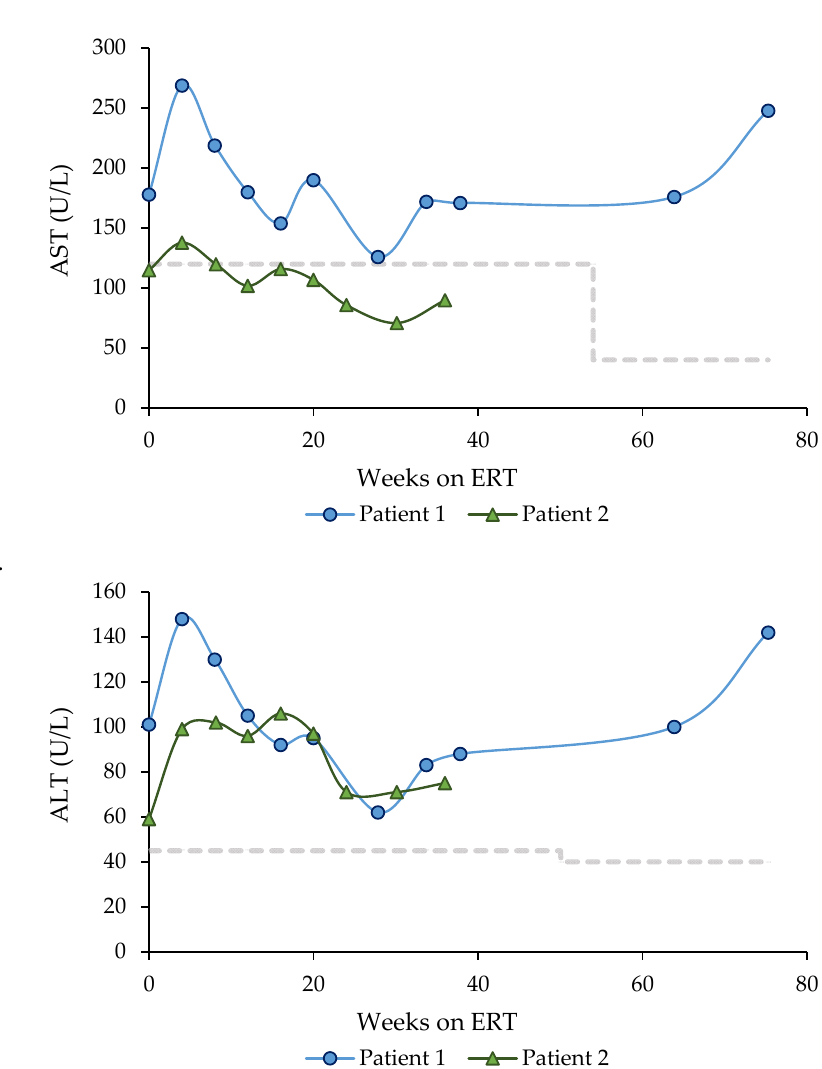
Figure 3. Evolution of serum CK, AST & ALT levels after ERT initiation in Patient 1 (started ERT < 3 months of age) (blue lines), and Patient 2 (started ERT < 1 month of age) (green lines). ( A ) Evolution of serum CK levels. The horizontal dashed line indicates the upper limit of the normal range (320 U/L, age 0 to 9 years). ( B ) Evolution of serum AST levels. The horizontal dashed line indicates the upper limit of the normal range (120 U/L, age < 12 months; 41 U/L, age > 12 months). ( C ) Evolution of serum ALT levels. The horizontal dashed line indicates the upper limit of the normal range (45 U/L, age < 12 months; 40 U/L, age 1 to 11 years).